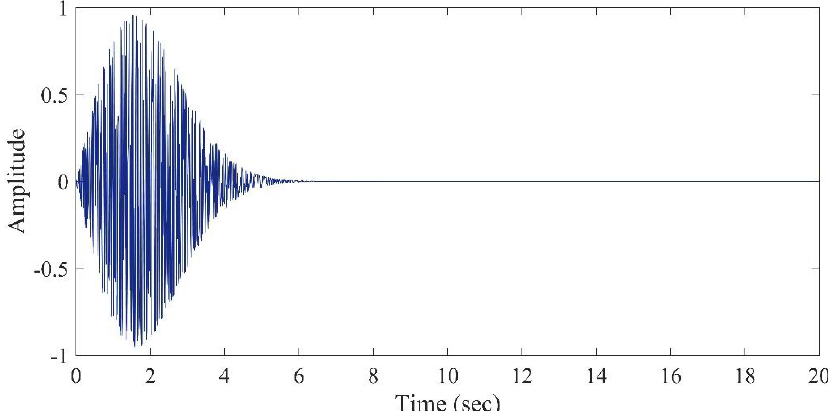
Figure 13. The nonstationary excitation.